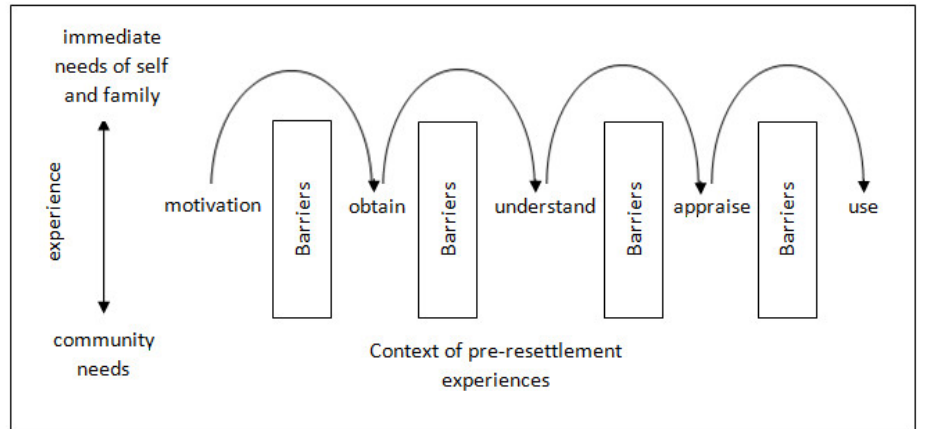
Figure 1. A model of the health information experiences of women of refugee background from Myanmar.